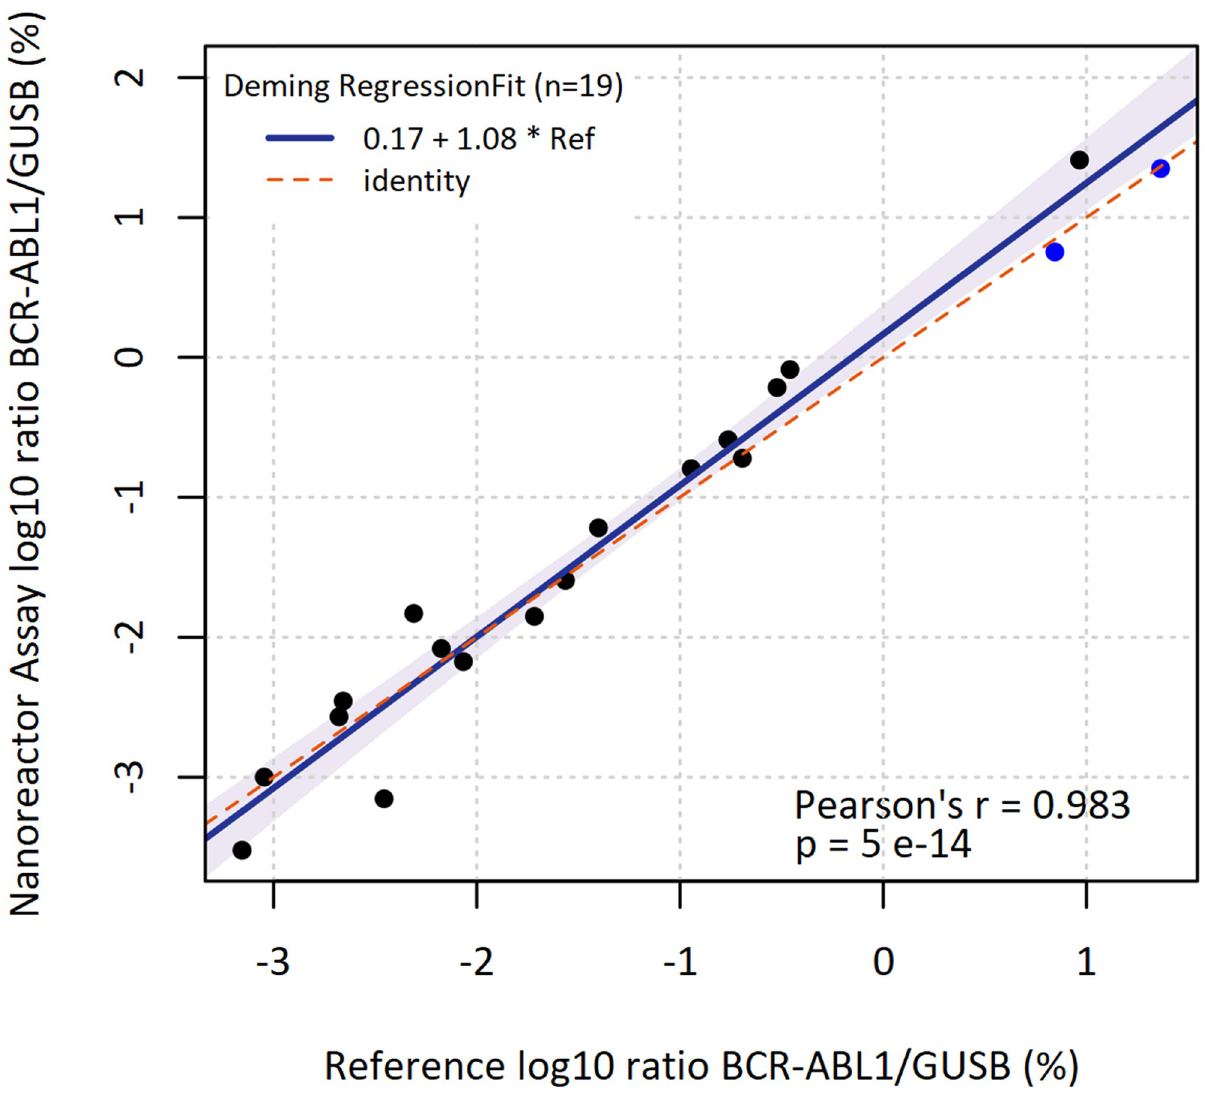
Fig 8. Deming regression for data obtained with the reference and the new method. Black, Poisson analysis of digital PCR data for BCR-ABL1; blue, Ct-value analysis of quantitative real-time PCR for BCR-ABL1, Ref = reference).